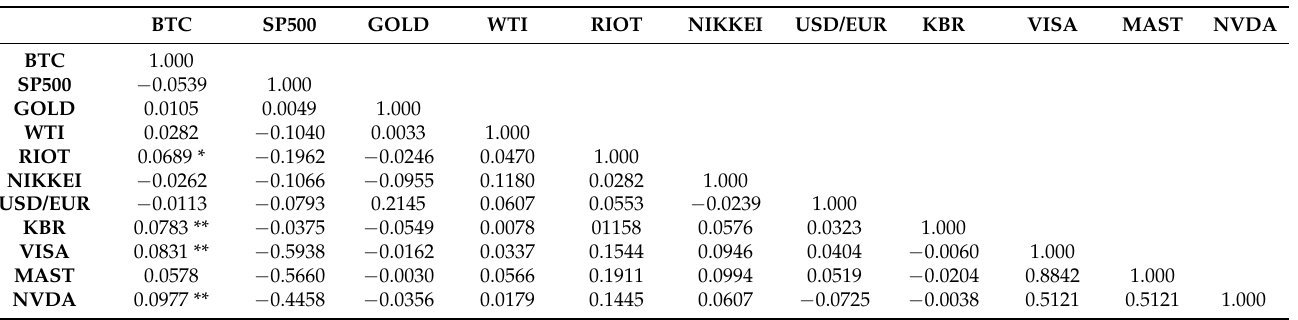
Table A1. Correlations